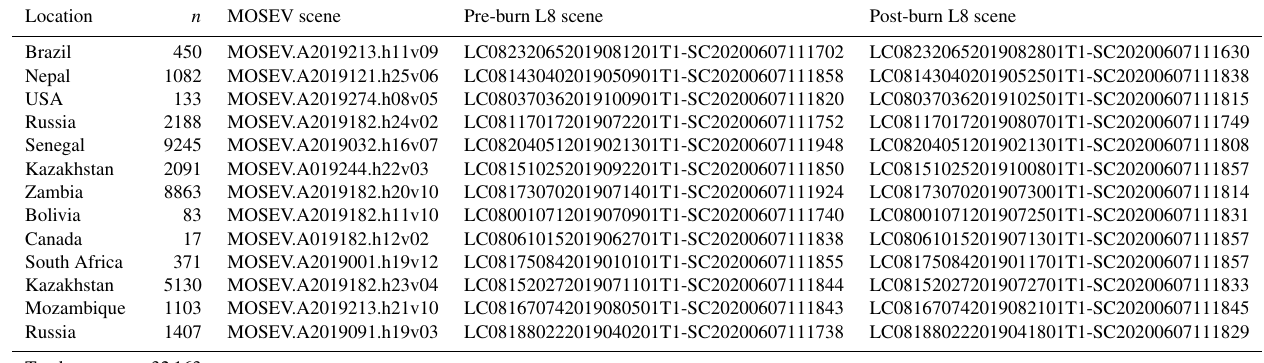
Table A1. Scenes and number of pixels ( n ) used to compare MOSEV and Landsat-8-derived (L8) burn severity indices (dNBR, RdNBR and post-burn NBR).